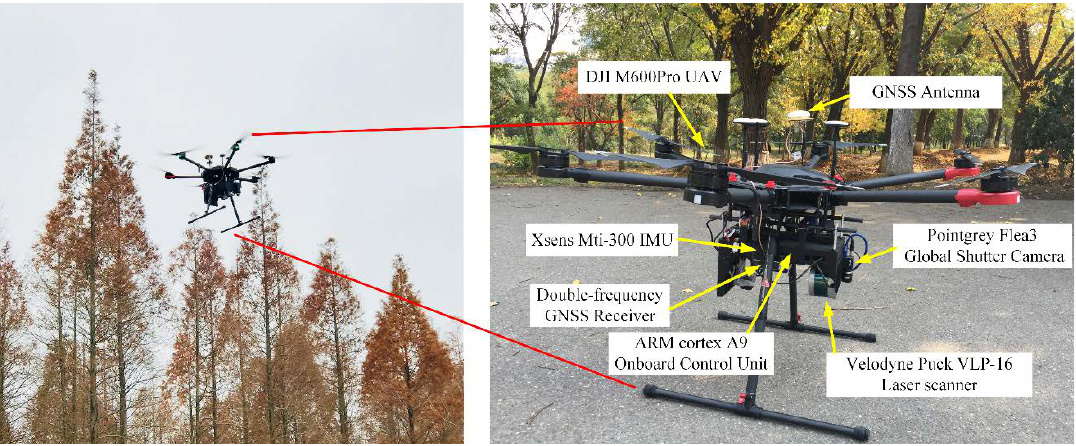
Table 1. Sensor specifications of the Kylin Cloud.